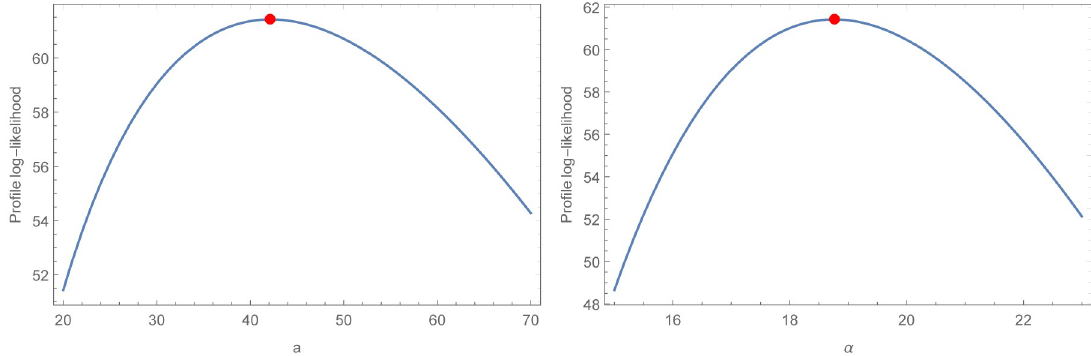
Fig 8. This figure discuses the behavior of the log-likelihood functions with a and α parameters of the second COVID-19 real data set. Which proves that the roots are global